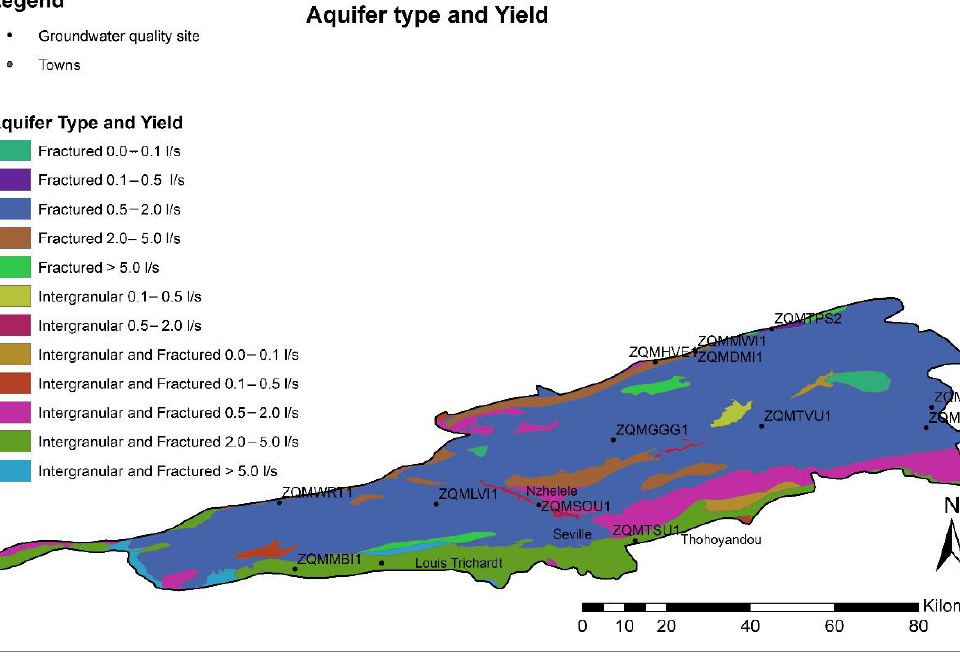
Figure 2. Hydrogeological settings of the Soutpansberg region .